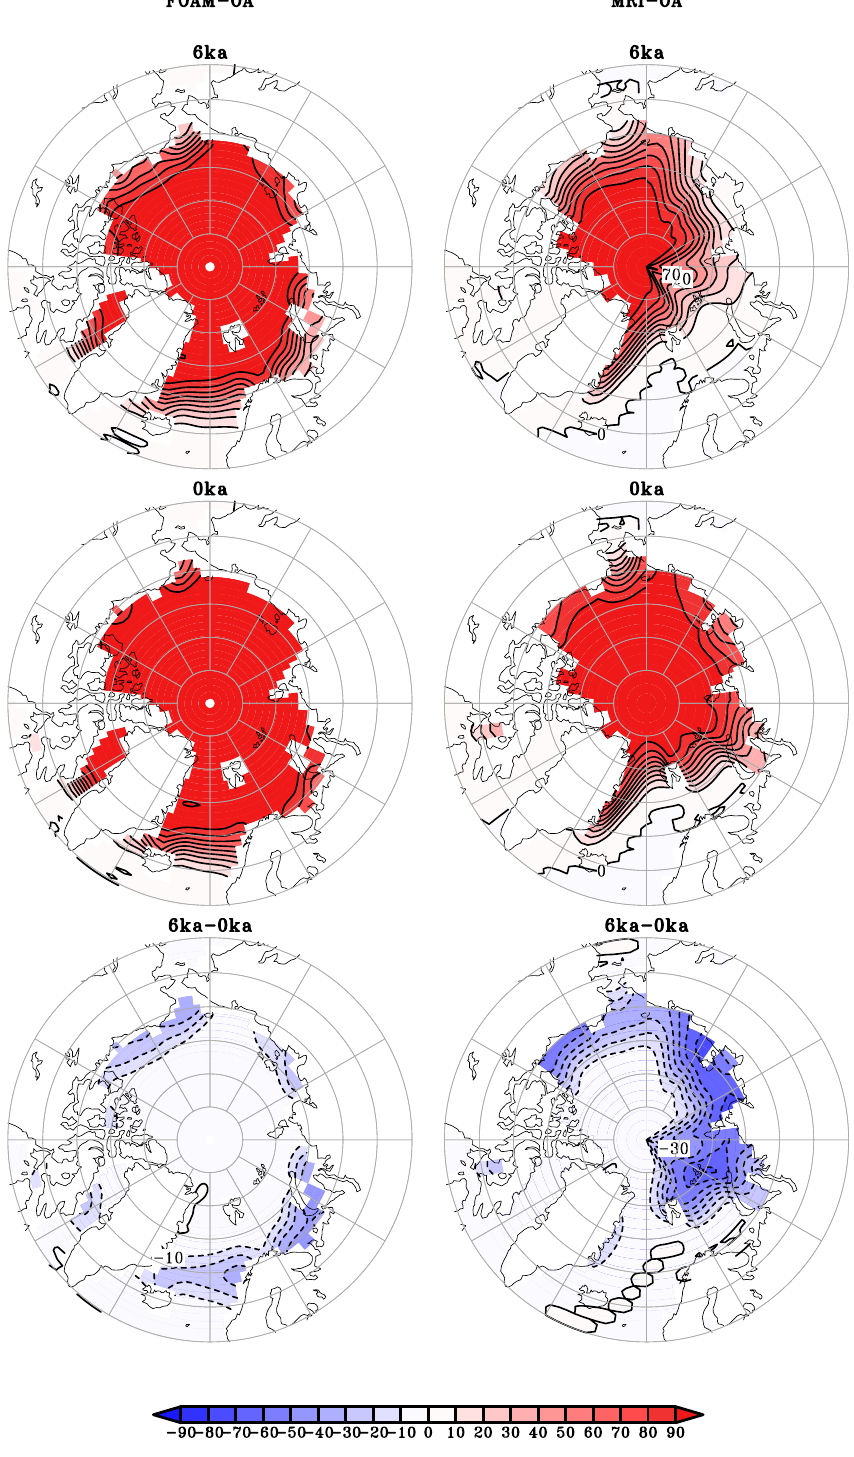
Fig. 8. Summer sea ice area fraction (%) in 6ka (top row), 0ka (middle row) and the change between 6ka and 0ka (low row). Left column is for FOAM-OA and right column is for